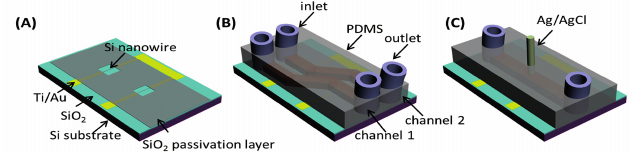
Figure 1. Schematic illustrations for the silicon nanowire field-effect transistor (SiNW-FET) chip ( A ); microfluidic channels during antibody modifications (dual-channel); ( B ) and biosensing measurements (single channel) ( C